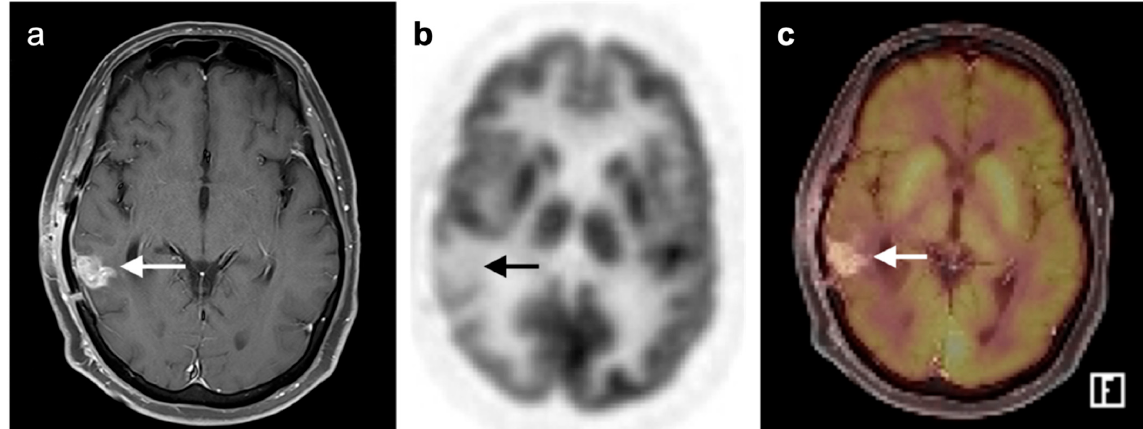
Figure 48. Radiation necrosis. ( a ) Axial Gd enhanced fat suppression T1 MRI shows a region of enhancement in the posterior right temporal lobe in a patient with a high ‐ grade glioma 8 weeks following radiation treatment (white arrow). ( b ) The region shows low activity on axial FDG PET (black arrow), consistent with radiation necrosis. ( c ) Fused axial PET ‐ MRI images help localize the region of interest precisely (white arrow). (black arrow), consistent with radiation necrosis. ( c ) Fused axial PET-MRI images help localize the region of interest precisely (white